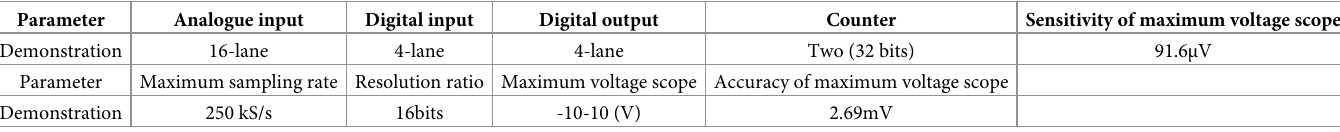
Table 1. Parameters of data acquisition